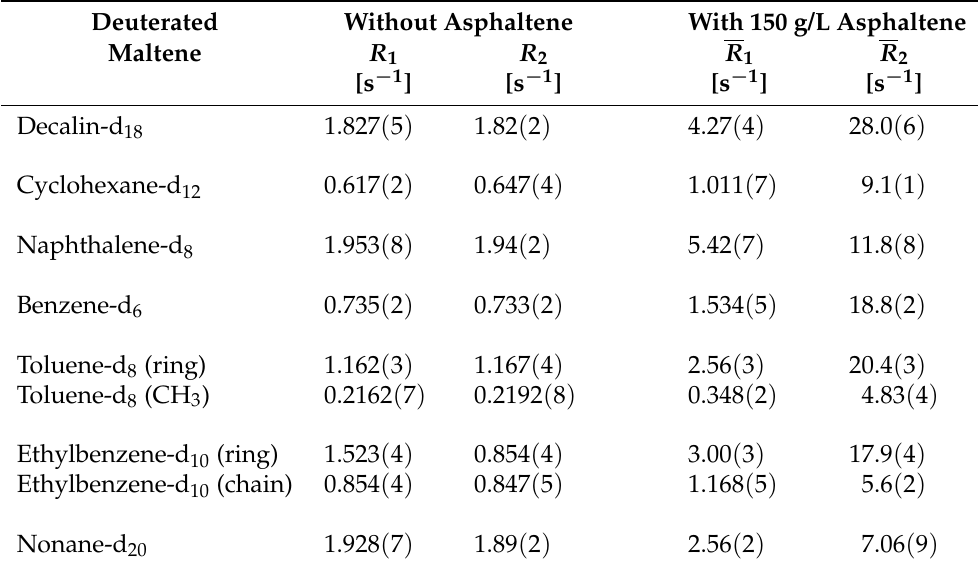
Table A3. (Mean) relaxation rate constants of the longitudinal ( R 1 ) and transverse ( R 2 ) relaxation of the deuterated maltenes in absence and presence of the